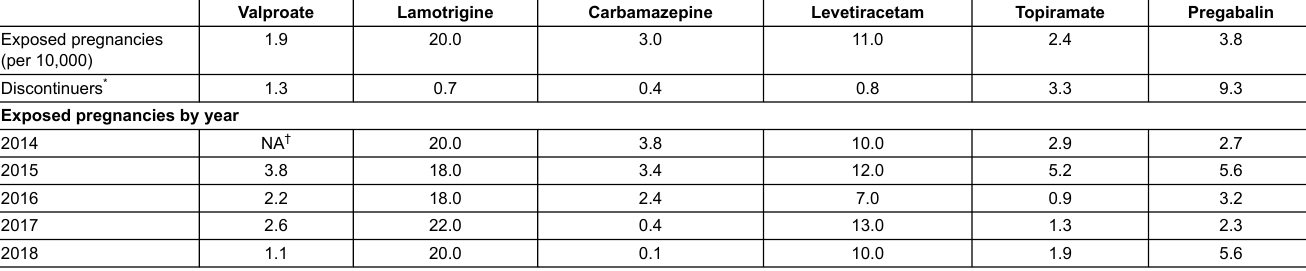
Table 2: Weighted prevalence of exposure to antiseizure drugs (per 10,000) during pregnancy (2014–18)